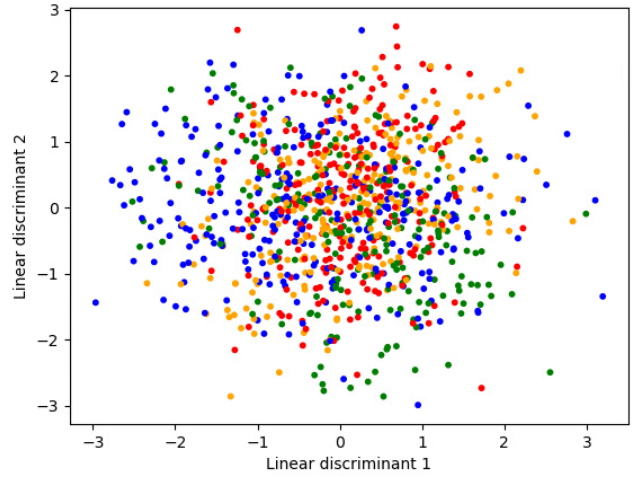
Figure 5. Data visualization in the 2D subspace maximizing the separation between classes (super- vised linear dimensionality reduction using linear discriminant analysis